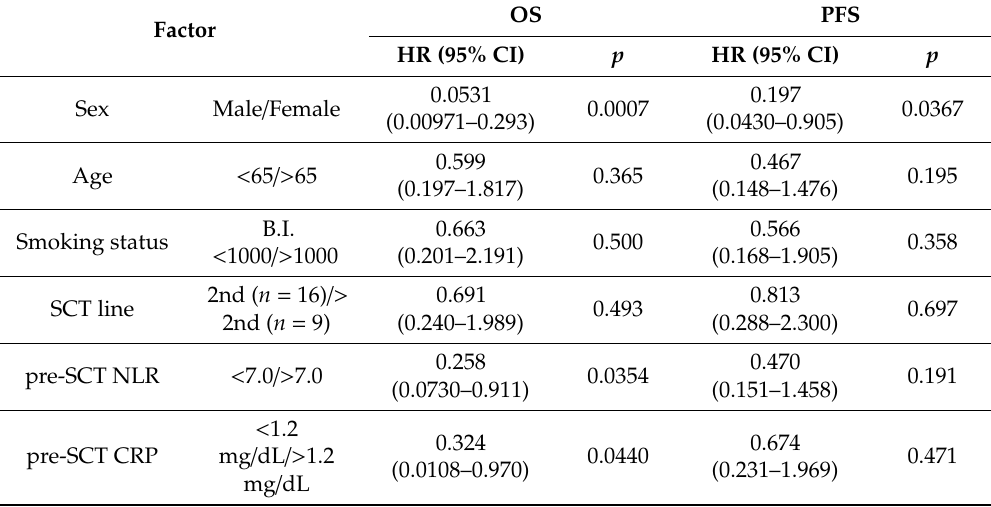
Table 4. The multivariate analysis of factors associated with overall survival and progression-free survival in patients administered salvage chemotherapy with PC (reference to PS, Sex, and Age).